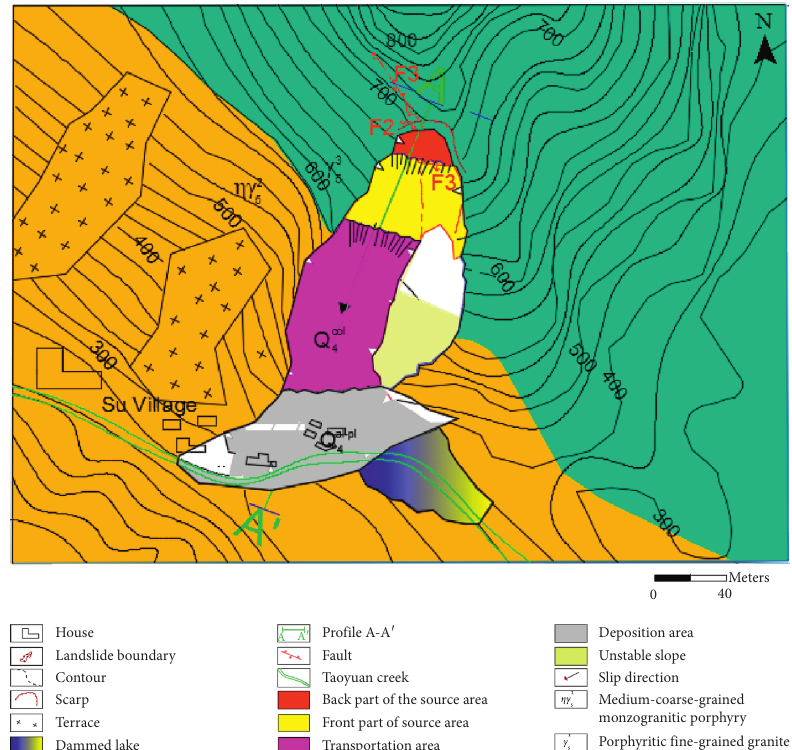
Figure 3: Schematic geological map and landslide feature of the Sucun rock